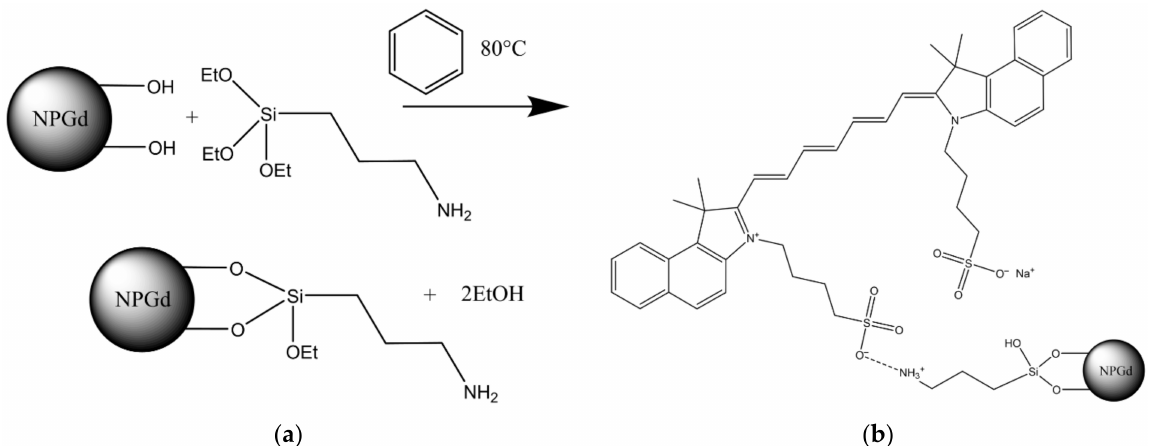
Figure 3. GF/TPO NP modification scheme: ( a ) Amino-spacer synthesis scheme; ( b ) coordination- ionic immobilization of ICG on an